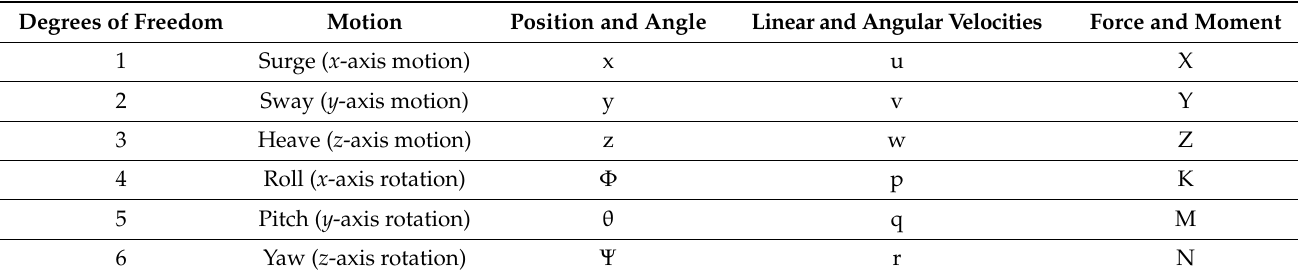
Table 1. Six degrees of freedom